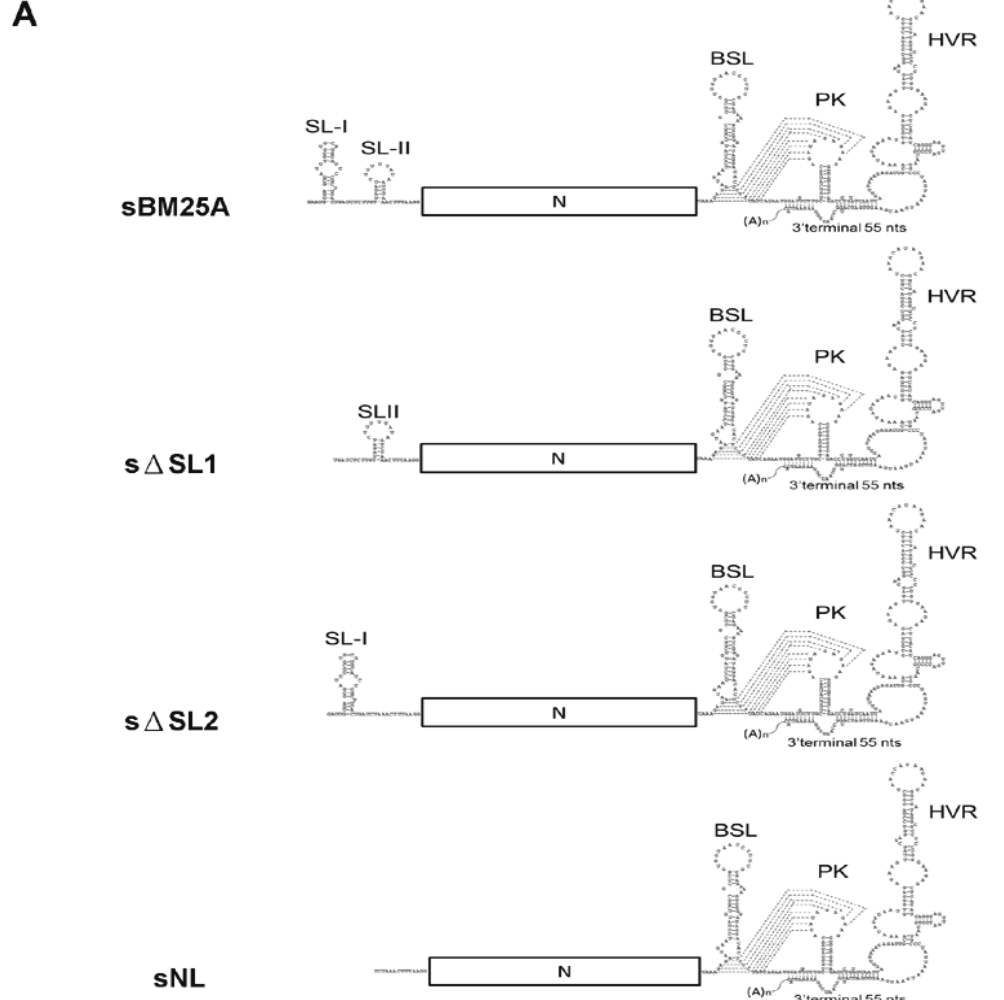
Figure 3. Identification of cis -acting elements within the leader sequence that are essential for ( − )-strand sgmRNA synthesis. ( A ) Constructs with deletions in the leader sequence of wt sBM25A. s Δ SL1: deletion of stem-loop I; s Δ SL2: deletion of stem-loop II; sNL: deletion of the leader sequence. SL: stem-loop; BSL: bulged stem-loop; PK: pseudoknot; HVR: hypervariable region. ( B ) The relative efficiency of ( − )-strand RNA synthesis between the constructs, as measured by RT-qPCR with (left panel) or without (right panel) head-to-tail ligation. Left panel: Control A: total cellular RNA from mock-infected cells. Control B: total cellular RNA from BCoV-infected cells. Control C: total cellular RNA from sBM25A-transfected mock-infected cells. Control D: a mixture of BCoV-infected cellular RNA extracted at 8 hpt and 200 ng of sBM25A transcript. Right panel: Control A: total cellular RNA from mock-infected cells. Control B: total cellular RNA from BCoV-infected cells. Control C: total cellular RNA from sBM25A-transfected mock-infected cells. Control D: total cellular RNA from s Δ SL1-transfected mock-infected cells. Control E: total cellular RNA from s Δ SL2-transfected mock-infected cells. Control F: total cellular RNA from sNL-transfected mock-infected cells. ( C ) Measurements of reporter-containing sgmRNA, 18S rRNA and M sgmRNA (from helper virus) at 8 hpt of VP0 by Northern blot analysis. The values (B) represent the mean ± SD of three individual experiments. *** p